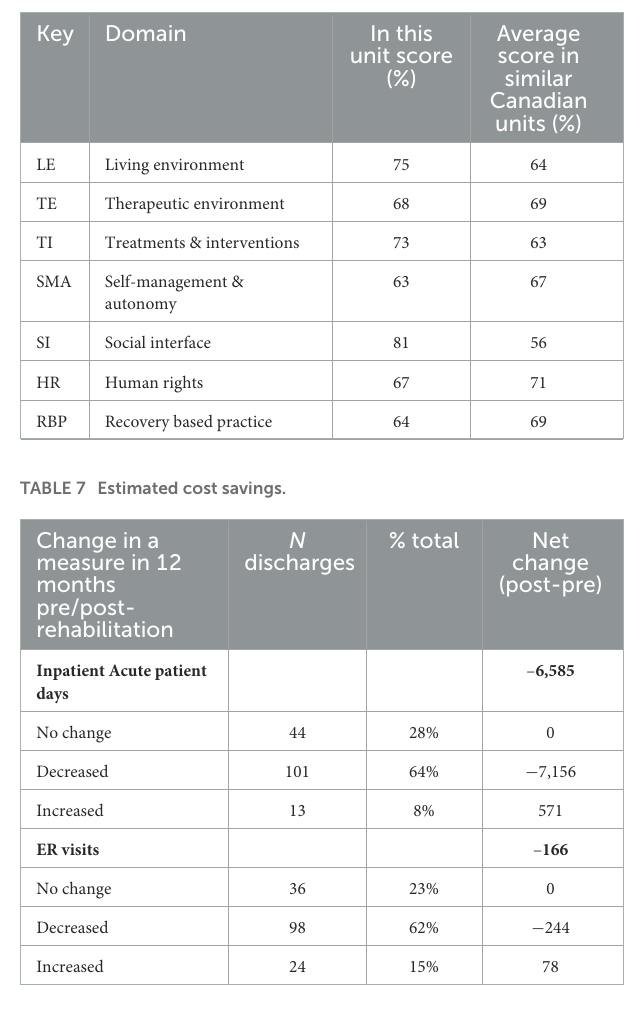
TABLE 6 Measurement of quality performance on different rehabilitation domains compared to the national average.